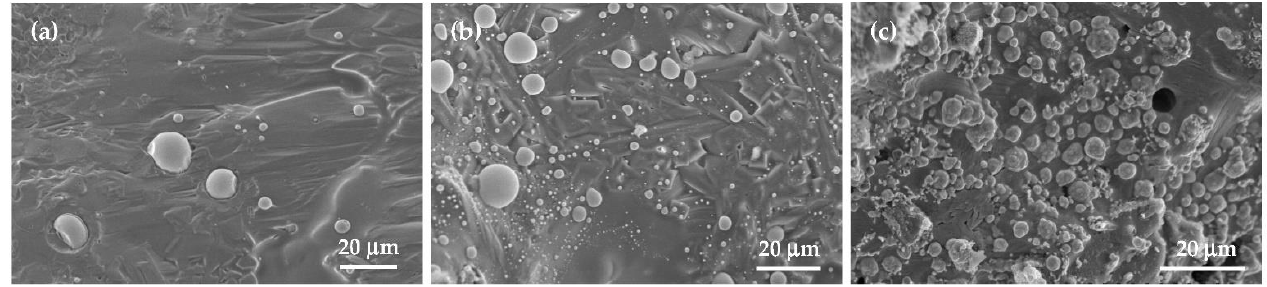
Figure 8. SEM micrographs of SHS products of ( a ) Reaction (1) of Fe-20% Si, ( b ) Reaction (2) of Fe-55% Si, and ( c ) Reaction (2) of Fe-66.7% Si.